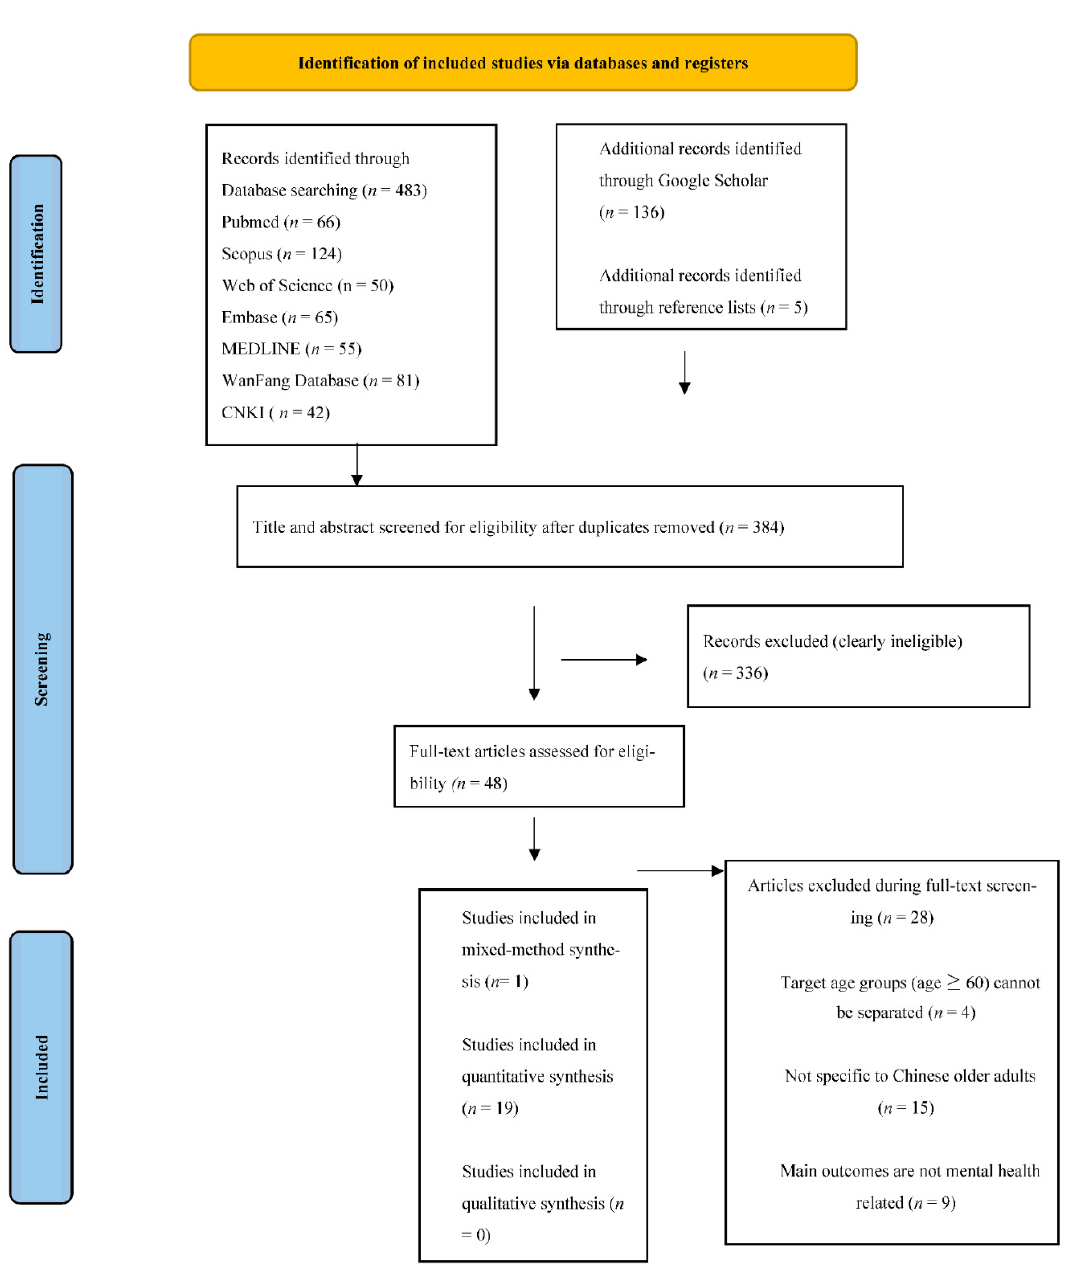
Figure 1. PRISMA flow chart of the study identification process for systematic reviews and meta- analysis, 2019.